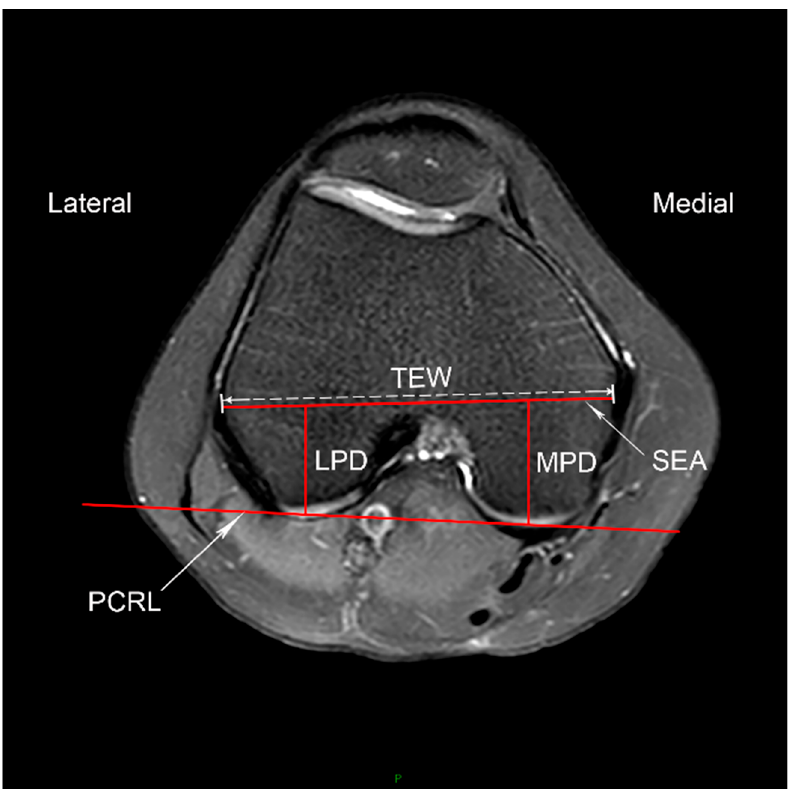
Figure 2. Posterior femoral condylar morphology. The axial MRI slice showing the complete femoral trochlea with cartilage and intact posterior femoral condyles is selected. The posterior femoral condyle reference line (PCRL) and the surgical transepicondylar axis (SEA) are shown. The width of the SEA (TEW), the distance between the SEA and the posterior cartilaginous margin of the lateral condyle (LPD) and medial condyle (MPD) are measured. The posterior condylar angle (PCA) is the angle between the SEA and PCRL.